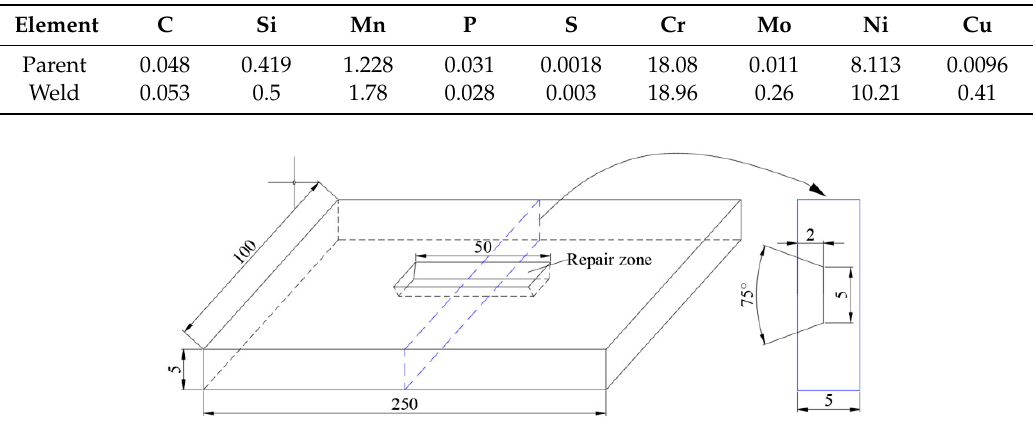
Figure 1. The schematic diagram of repaired specimen. Table 1. The chemical compositions of the parent metal and the filler wire (wt %).